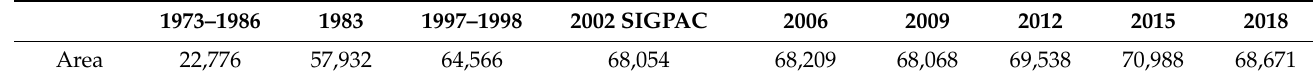
Table 3. Area (m 2 ) of sludge (RMSE x,y ≤ 1.00 m